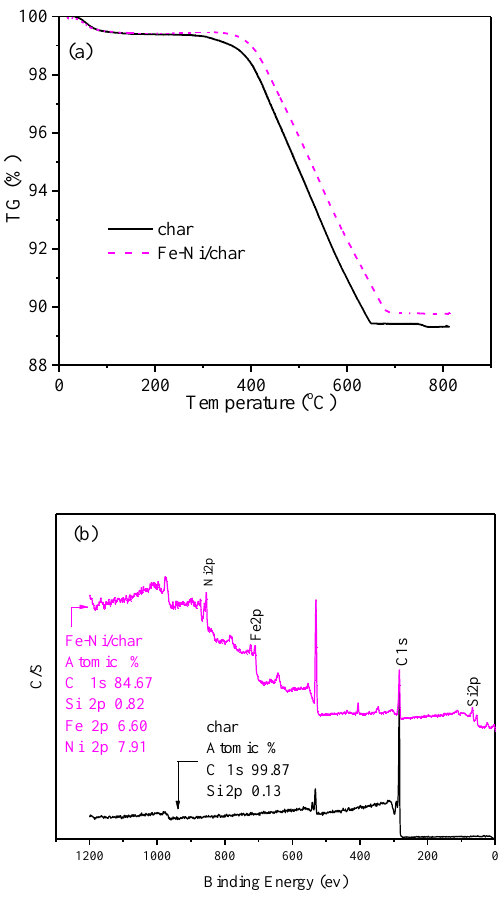
Figure 2. TG curves ( a ) and XPS ( b ) analysis of different fresh catalysts.